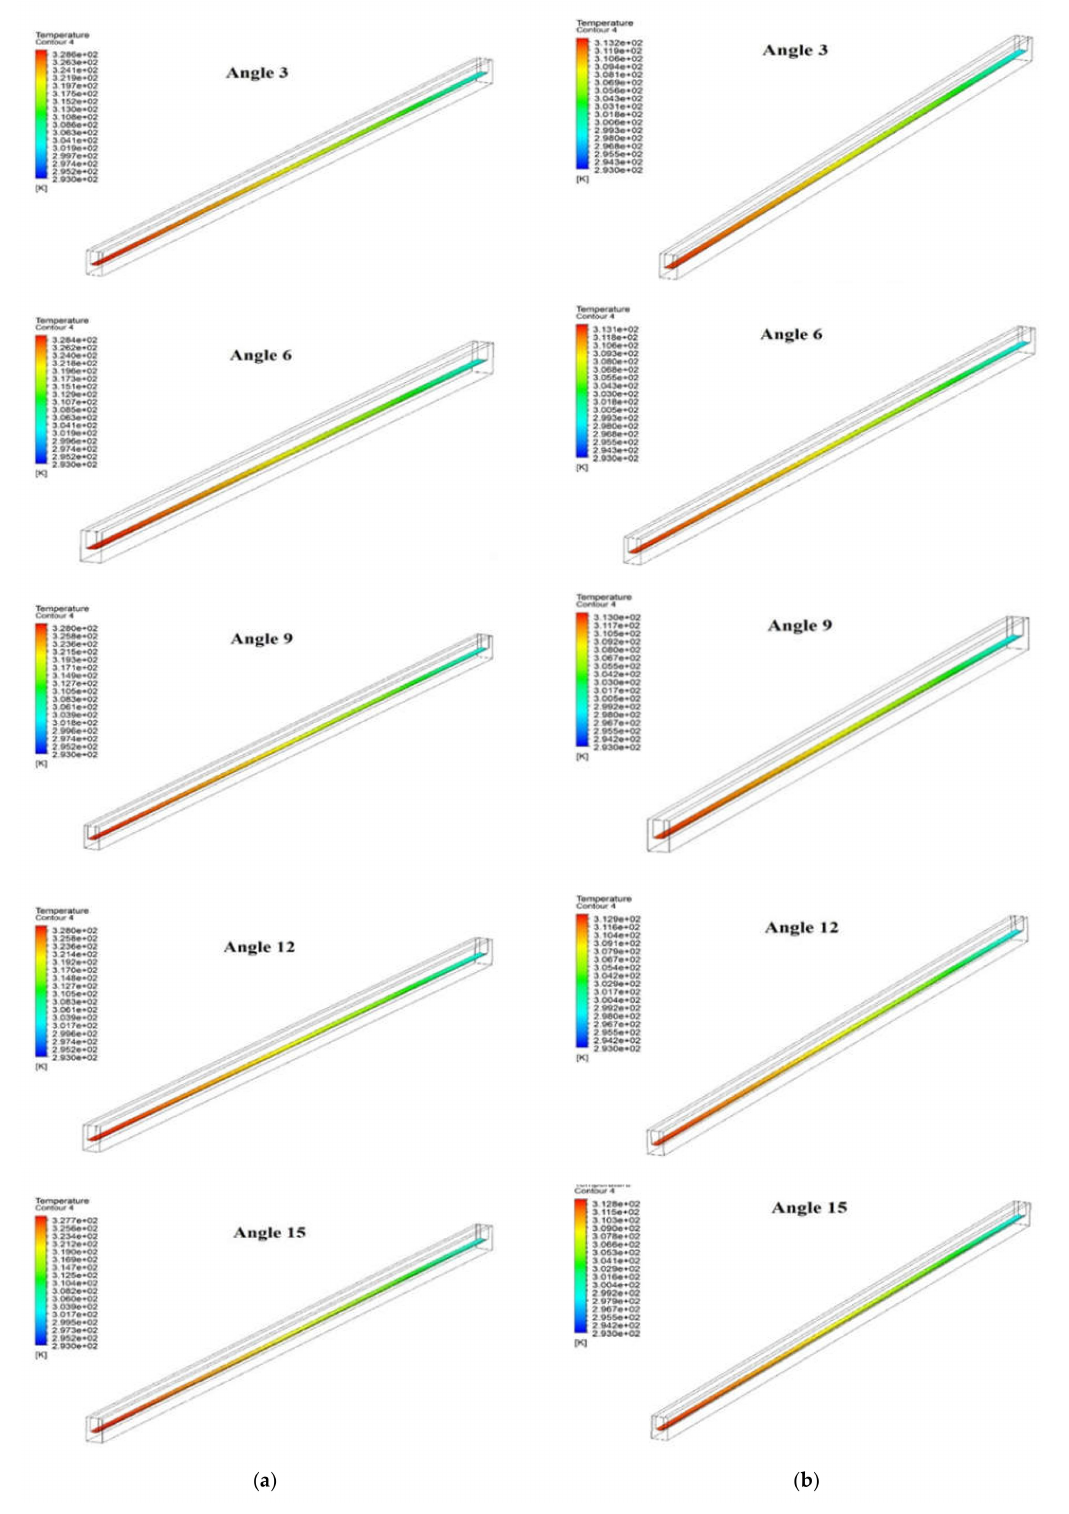
Figure 8. Temperature Contour at base of microchannel at ( a ) Reynolds Number = 200 and ( b ) Reynolds Number =